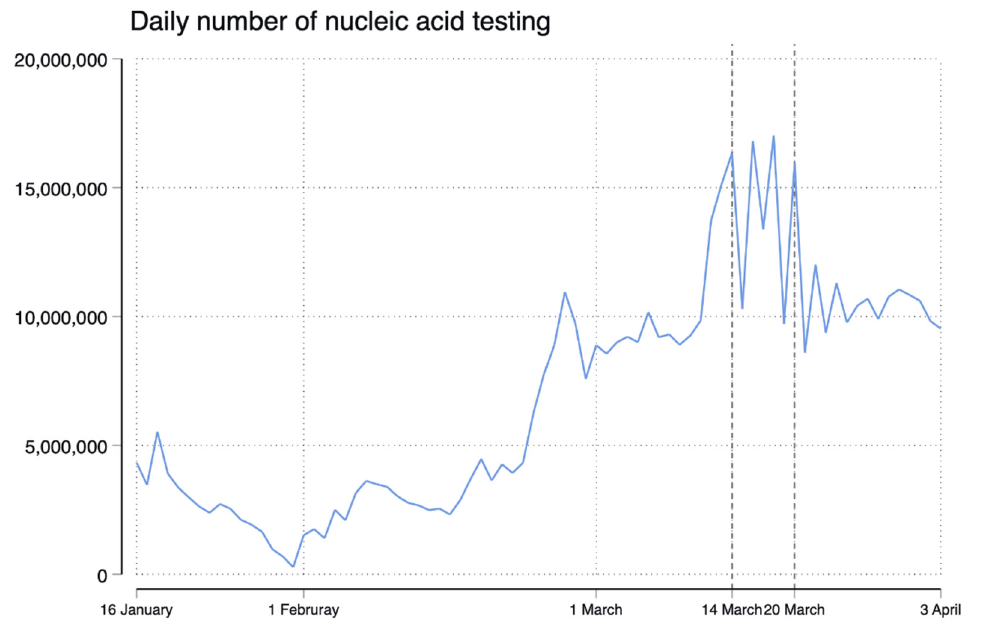
Figure 2. Trend in daily number of nucleic acid testing during 6 January to 3 April 2022 in Shenzhen, China.